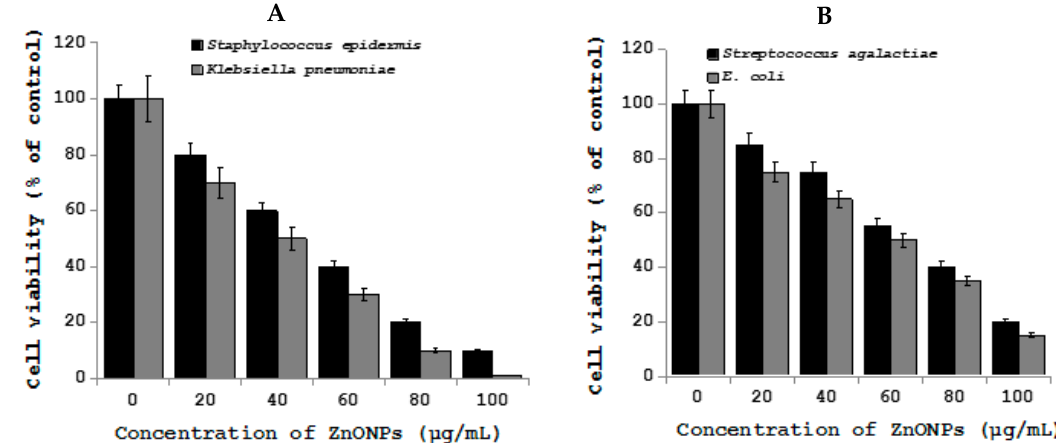
Figure 7. Antibacterial activity of ZnO-NPs on Staphylococcus epidermis , Klebsiella pneumoniae , Streptococcus agalactiae and E. coli . Staphylococcus epidermis , Streptococcus agalactiae , Klebsiella pneumoniae , and E. coli cells were incubated with various concentrations of ZnO-NPs. ( A ) Cell viability of Staphylococcus epidermis and Klebsiella pneumoniae treated with ZnO-NPs. ( B ) Cell viability of Streptococcus agalactiae and E. coli treated with ZnO-NPs. Bacterial survival was determined at 24 h by a CFU count assay. The experiment was performed with various controls including a positive control (ZnO-NPs and NB, without inoculum) and a negative control (NB and inoculum, without ZnO-NPs). The results are expressed as the means ± SD of three separate experiments, each of which contained three replicates. Treated groups showed statistically significant differences from the control group by Student’s t test ( p < 0.05).